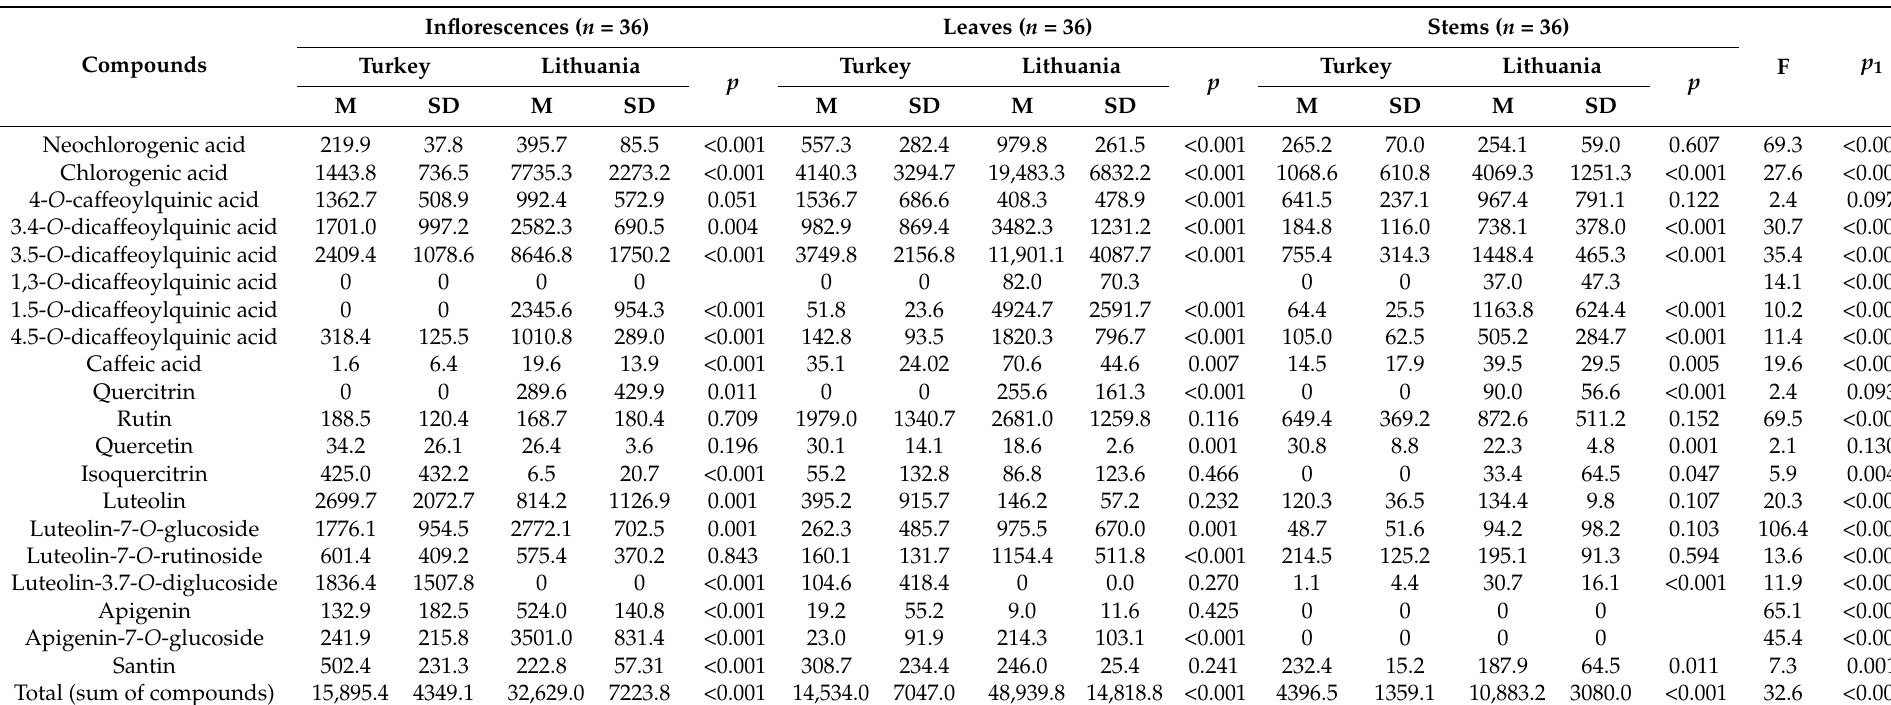
Table 1. The mean quantities ( µ g/g, DM) of phenolic compounds in inflorescences, leaves, and stems of Achillea millefolium in Turkey and Lithuania and comparison of their differences ( p ≤ 0.05) according to t -test, as well as differences in compounds among plant organs for all populations by ANOVA ( p 1 ). Inflorescences ( n = 36) Leaves ( n = Compounds